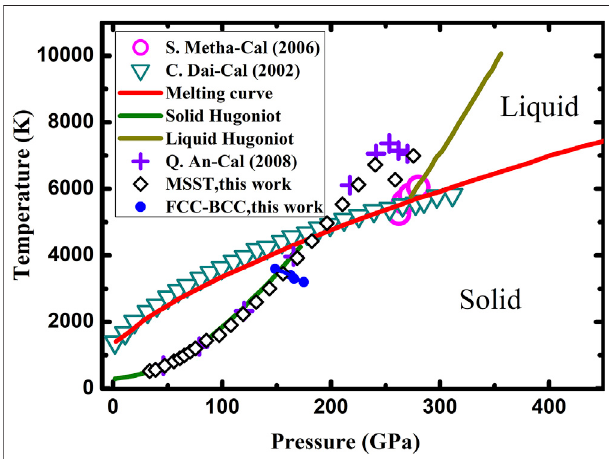
FIGURE 3 | Phase diagram of compressed copper. The blue dots denote thermodynamic equilibrium states, which indicate that the Gibbs